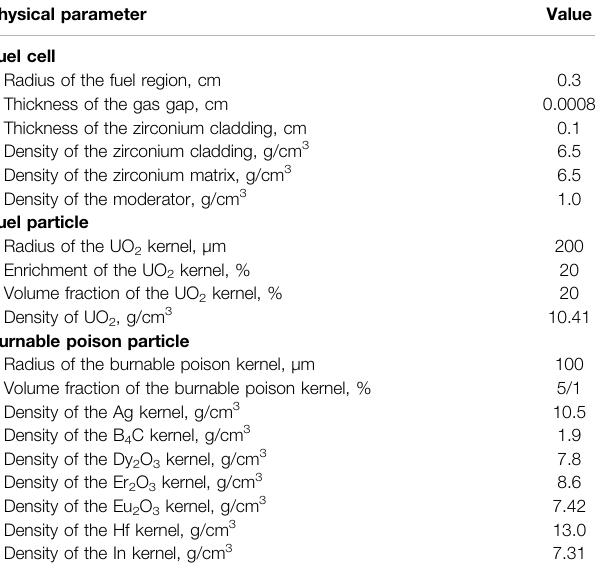
TABLE 1 | Parameters of the calculation